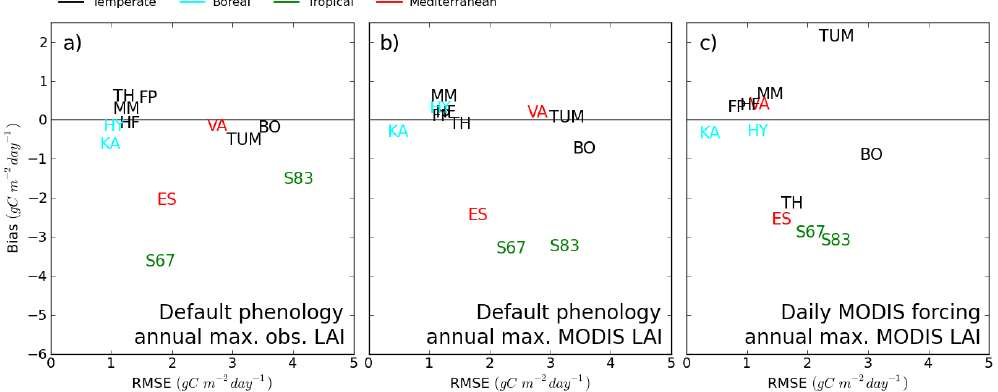
Figure 5. Comparison of modelled and observed GPP using bias and RMSE (computed using anomalies) at the 12 FLUXNET sites (HF: Harvard Forest; VA: Vaira Ranch; MM: Morgan Monroe; HY: Hyytiala; TH: Tharandt; TUM: Tumbarumba; ES: El Saler; FP: Fort Peck; KA: Kaamanen; S67: Santarem Km67; S83: Santarem Km83; BO: Bondville) for three sets of model simulations: (a) default phenology model with locally observed annual maximum LAI (data values used same as in Fig. 2a (local-F)); (b) default phenology model with annual maximum MODIS LAI (model simulations local-FNM); and (c) daily MODIS forced model simulations with annual maximum MODIS LAI (model simulations local-FM). The site labels are coloured according to their climate zone (Table